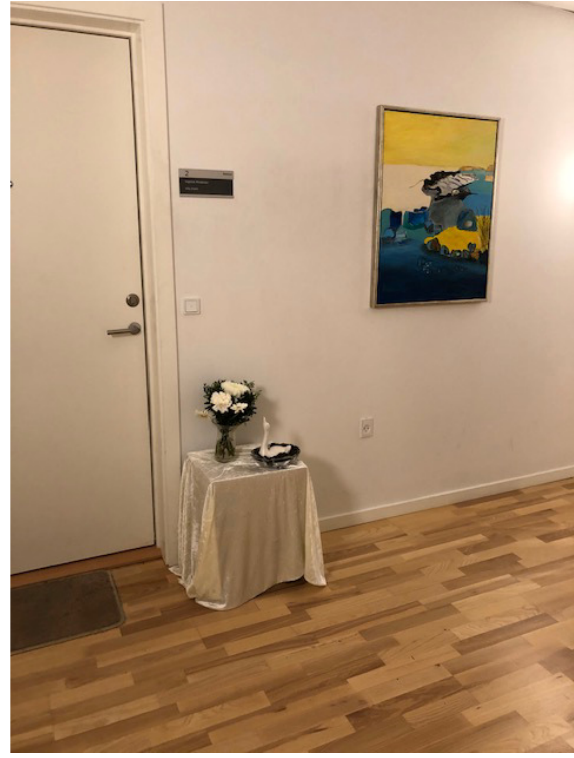
Figure 2. Hallway, Five Sisters. Scale, material, and design can enable or hinder social interaction. Residents who are allowed to put personal stuff in the hallways find it socially inviting. Source: Mechlenborg and Hauxner (2021, p.